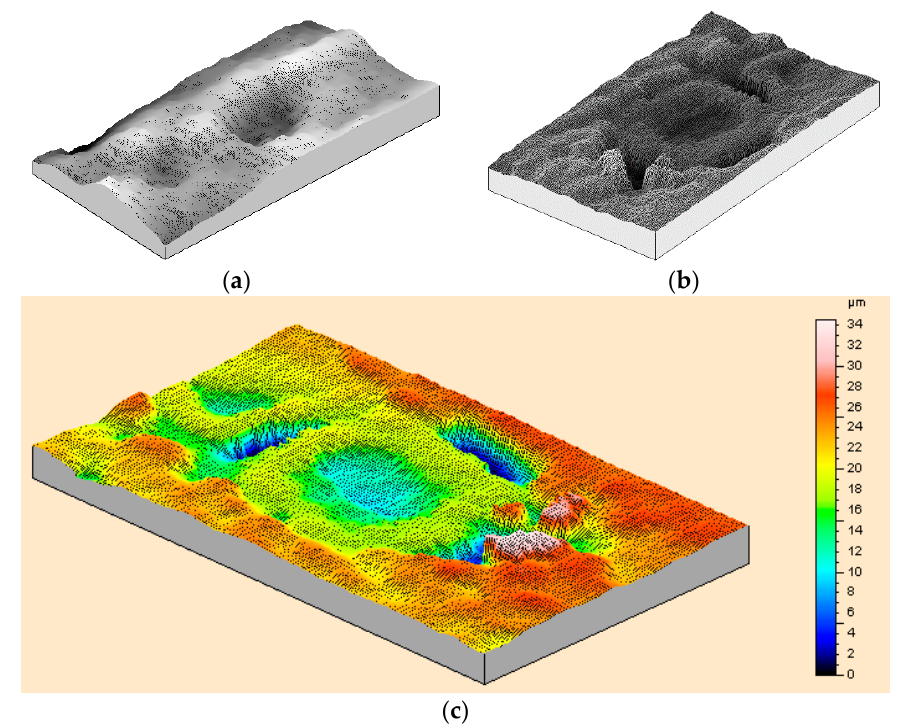
Figure 3. Confocal profilometry images of the wood cell wall in hot-oil modified wood samples before and after plasma treatment: ( a ) Two bordered pits in the cell wall of a wood sample modified with hot-oil; ( b ) and ( c ) Bordered pit in the cell wall of a wood sample modified with hot-oil and then treated with plasma for 1333 s. Note that the cell wall around the bordered has been etched but the central part of the pit is intact.